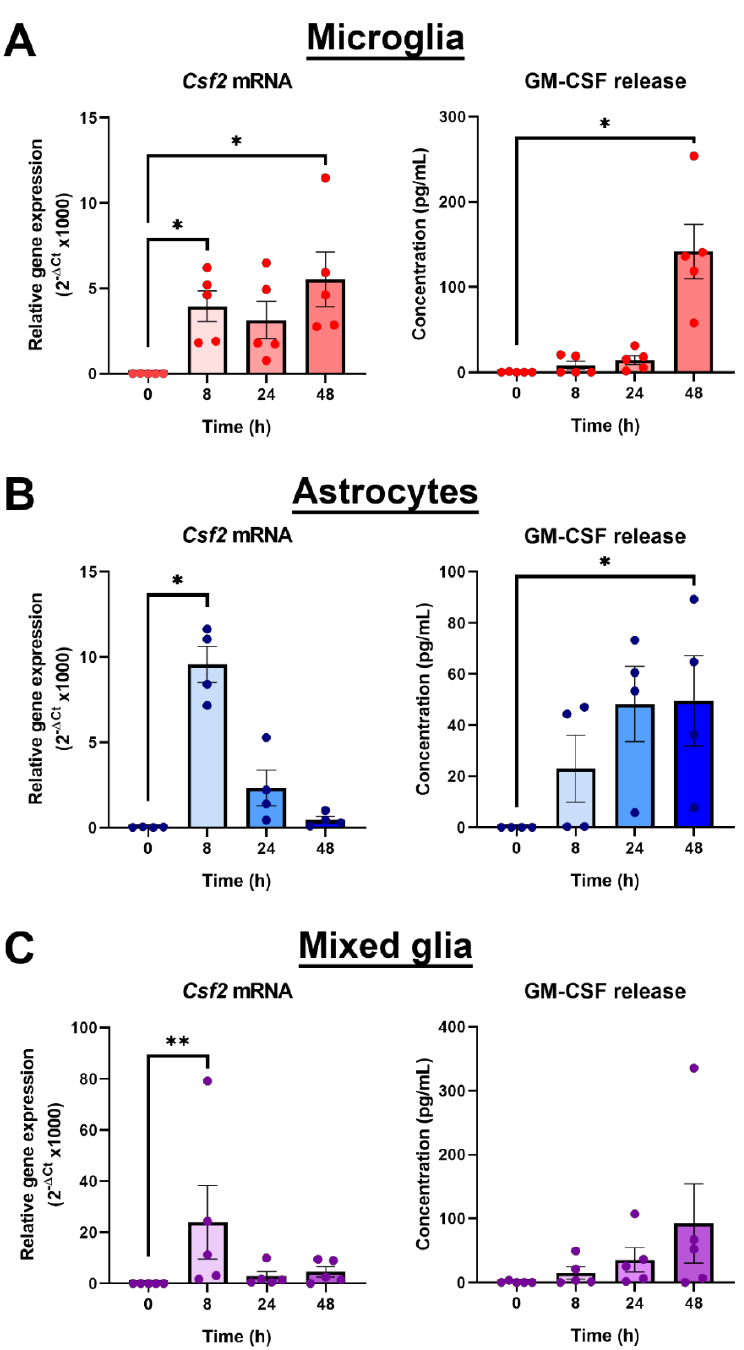
Figure 3. Microglia are the main resident CNS glial source of GM-CSF. Time course of GM-CSF upregulation by LPS (10 ng/mL) in: ( A ) pure microglial cultures, ( B ) pure astrocyte cultures and ( C ) mixed glial cultures, using RT-qPCR and ELISA to measure gene expression and protein release into the cell media, respectively. Gene expression is displayed as relative gene expression (2 −ΔCt ) and protein concentration is in pg/mL. Statistical analysis was determined using Friedman’s tests with p < 0.05 ( n = 4–5 independent experiments on separate cultures). * p < 0.05, ** p <